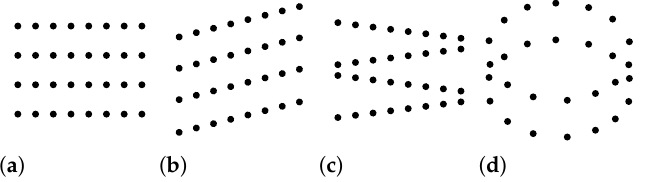
Figure 2. Scan patterns for basic types of sensors [49,52,53]: ( a ) line scanner or fiber scanner pattern; ( b ) rotating polygon or rotating mirror pattern; ( c ) oscillating or swinging mirror pattern; and ( d ) conical, elliptical, or Palmer scan pattern.